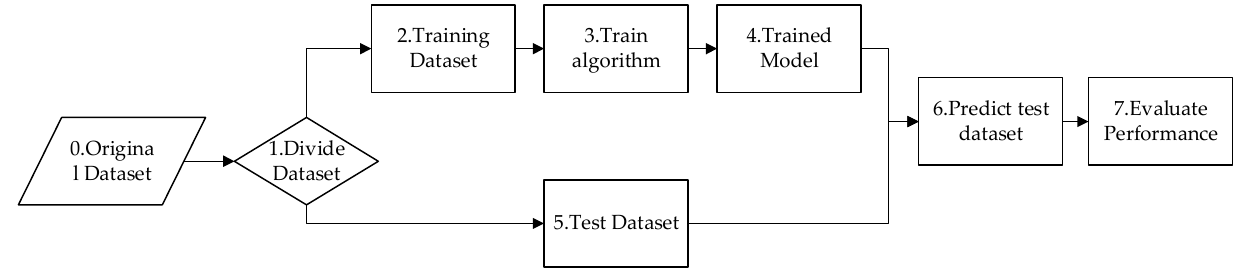
Figure 1. Machine learning flowchart in this experiment.